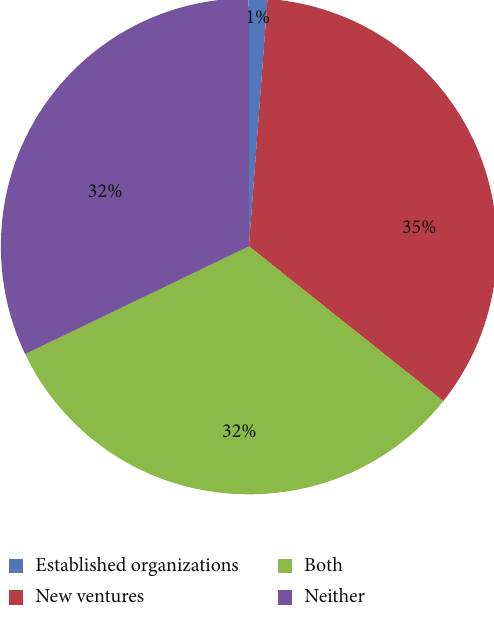
Figure 3: Focus of entrepreneurship